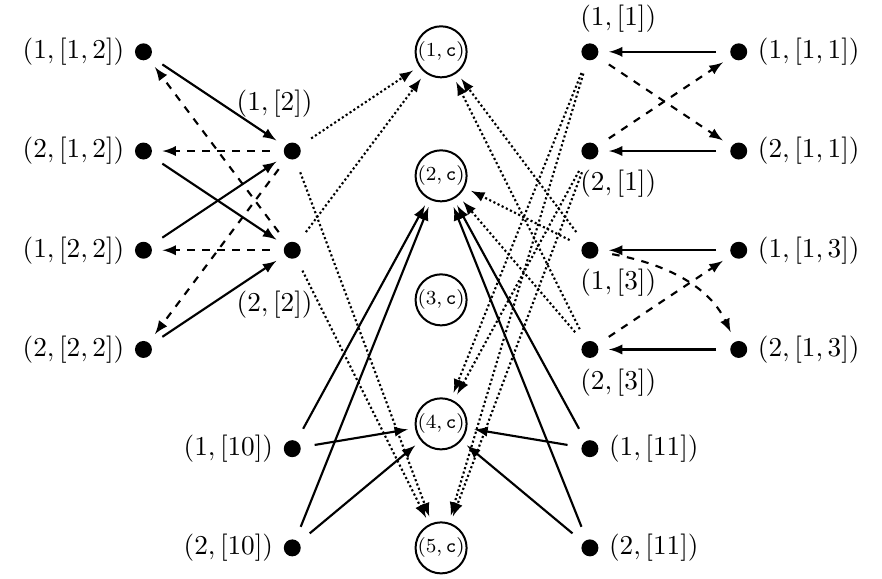
Figure 4: Orientation D